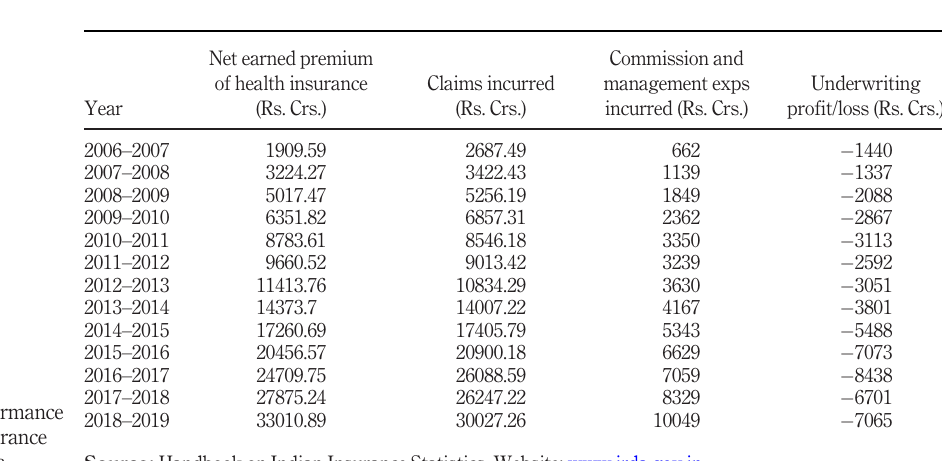
Figure 1. Chart on health